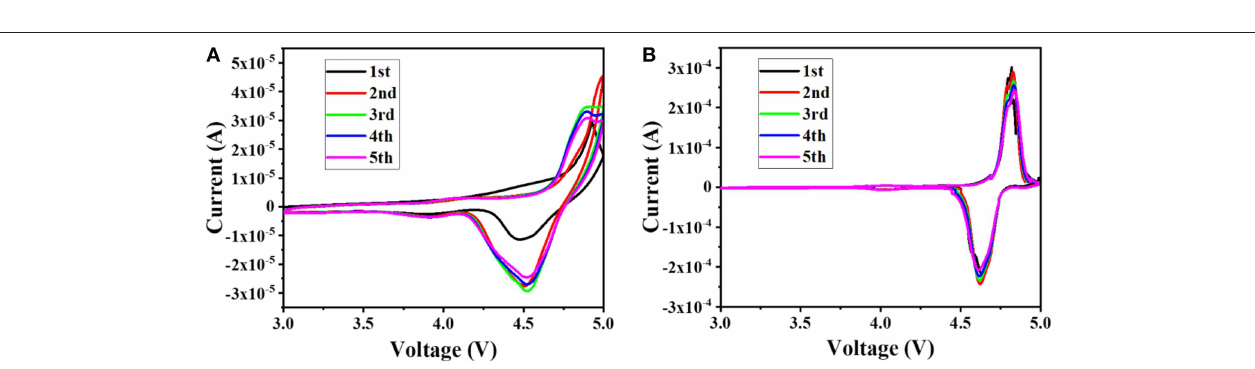
FIGURE 3 | CVs of Li/LNMO cell with no additive (A) and with 0.5 wt.% PTSI (B) , at a sweep rate of 0.1mV s − 1